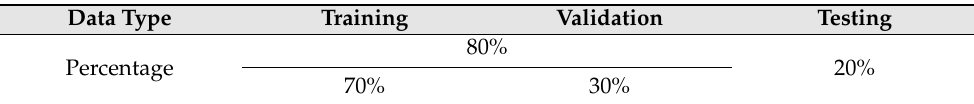
Table 9. R4 Drone Audio